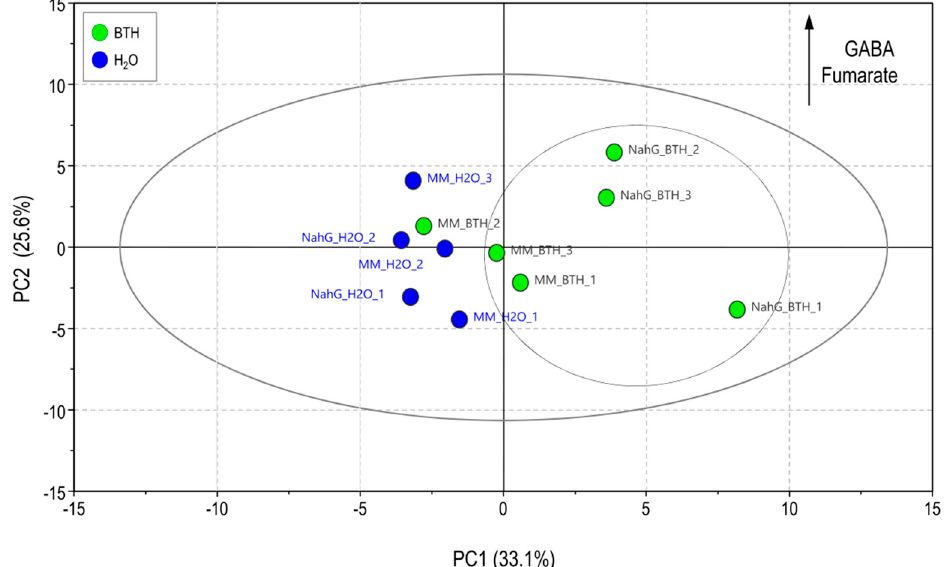
Figure 5. Score plot of principal component analysis (PCA) based on the characteristic ion of the mass spectra from the primary metabolites measured in the m/z range 35–900, of the Money Maker (MM) and NahG tomato plants after at 48 h after BTH treatments (green; leaves after BTH treatments; blue; leaves after H 2 O